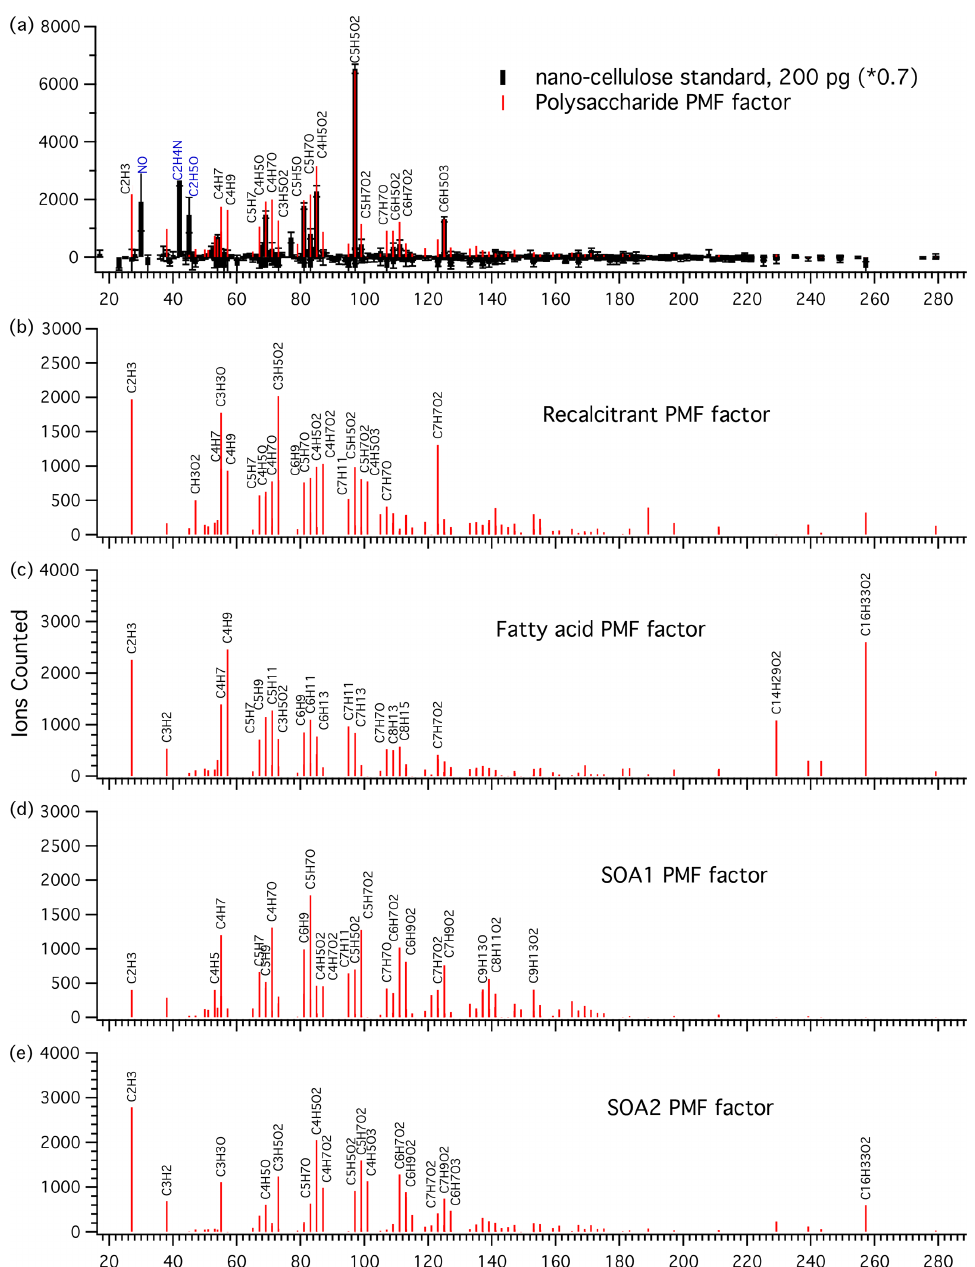
Figure 3. (a) Mass spectrum of nanocellulose standard (black sticks) and the polysaccharide PMF-derived factor (red sticks) attributed to polysaccharidal aerosol material. The peaks C 6 H 5 O + and C 5 H 5 O + were used to scale the PMF factor to the standard for calibration. 3 2 was the most characteristic polysaccharide peak and C 5 H 5 O + was the major polysaccharide peak. This 2µL 0.1mgL − 1 standard C 6 H 5 O + 3 2 is equivalent to 0.6µg collected on a filter and to an ambient sample with an air polysaccharide concentration of roughly 0.05µgm − 3 . Large peaks in the standard which were excluded from the PMF analysis are labeled in blue (N-containing species and overdominant C 2 H 5 O + ). (b) Recalcitrant PMF factor. The most characteristic feature of this factor is a C 7 H 7 O + peak consistent with benzoic acid. (c) Fatty acid 2 PMF factor. This factor is characterized by strong C 14 H 29 O + and C 16 H 33 O + peaks and several hydrocarbon fragments. (d) SOA1 PMF 2 2 factor and (e) SOA2 PMF factor, attributed to secondary organic